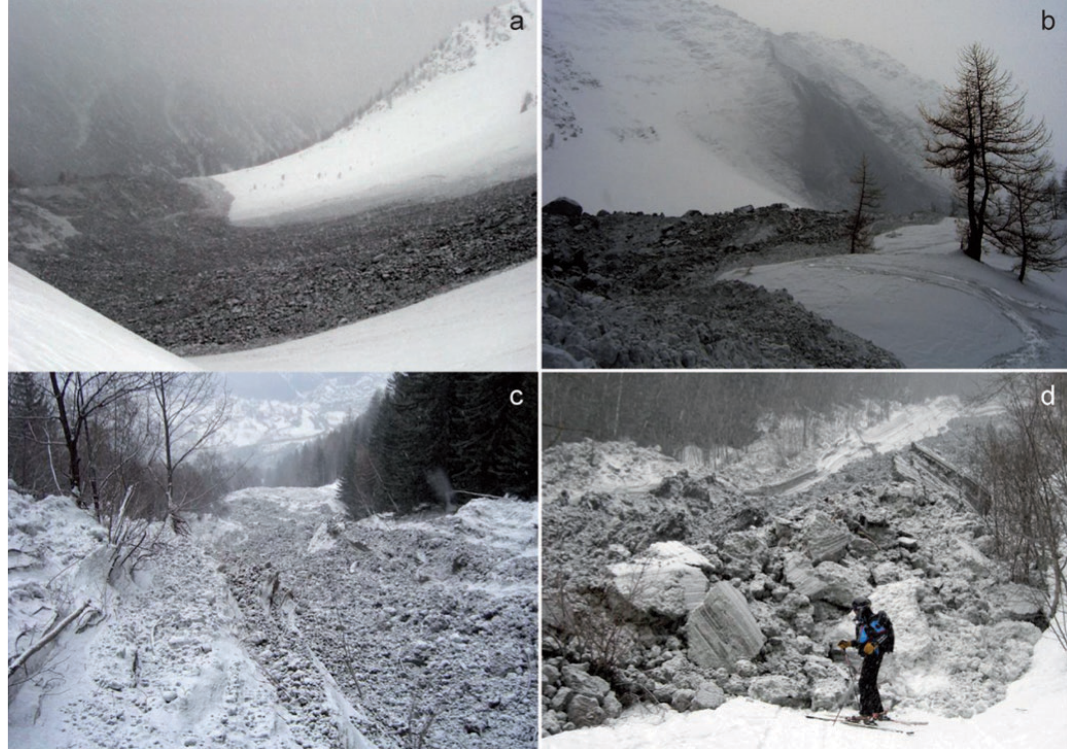
Fig. 5. Snow and rock deposit of the rock avalanche at different elevations (25 December 2008, G. Grange). (a) 2050–2250ma.s.l.; (b) 2050m; (c) 1500m; (d)